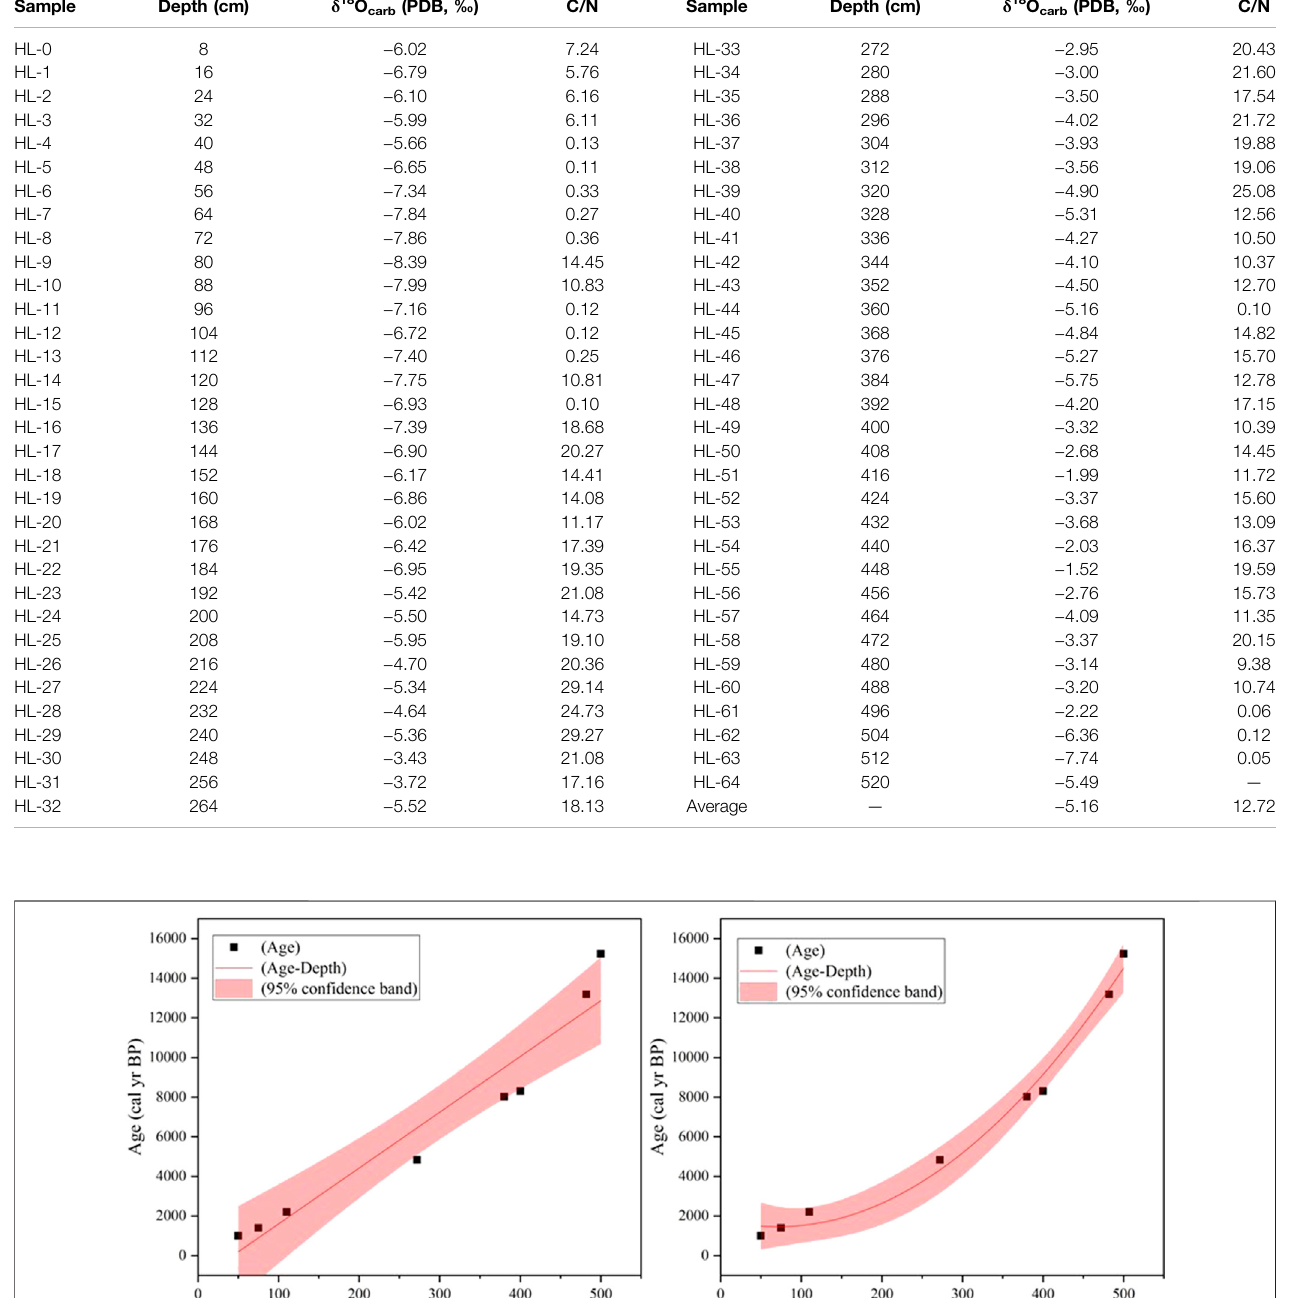
Frontiers in Earth Science |